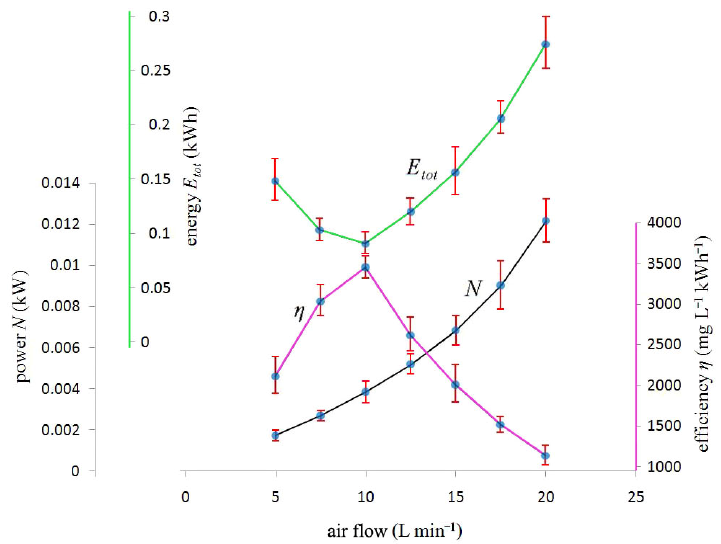
Figure 3. Black line: Power N (kW) in the ordinate vs. air flow (L min − 1 ) in the abscissa. Green line: The ordinate total energy E tot (kWh) spent to complete the substrate biodegradation. Purple line: The ordinate efficiency η (mg L − 1 kWh − 1 ) obtained for each series of substrate biodegradation